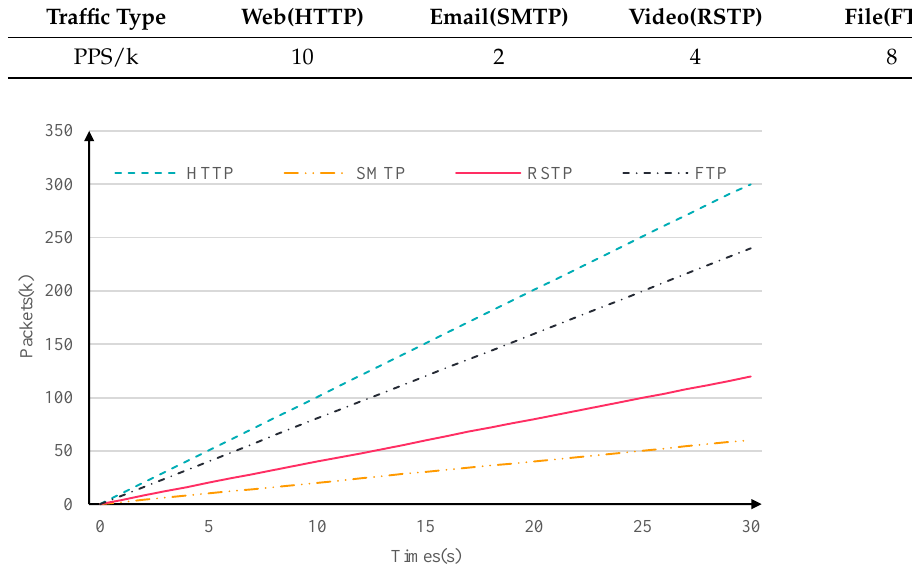
Figure 11. Replay Figure 11. Replay results.